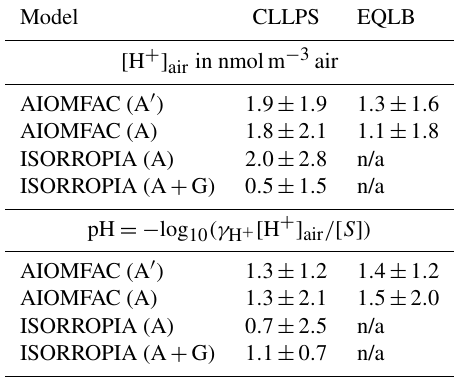
Table 1. [H + ] air and pH predicted for PM 2 . 5 at SOAS CTR (me- dian ± 1 standard deviation) under conditions of complete liquid– liquid phase separation between the organic-rich and electrolyte- rich phases (CLLPS) or in a full equilibrium calculation in which phase separation was calculated based on composition (EQLB). Model CLLPS